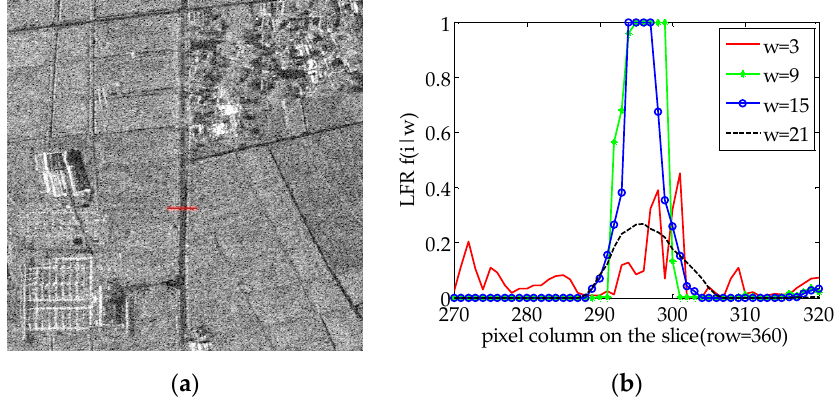
Figure 12. ( a ) An image slice marked in red; ( b ) line feature responses of image slice under different window widths (the abscissa axis denotes the columns of pixels and the row number is fixed to 360).